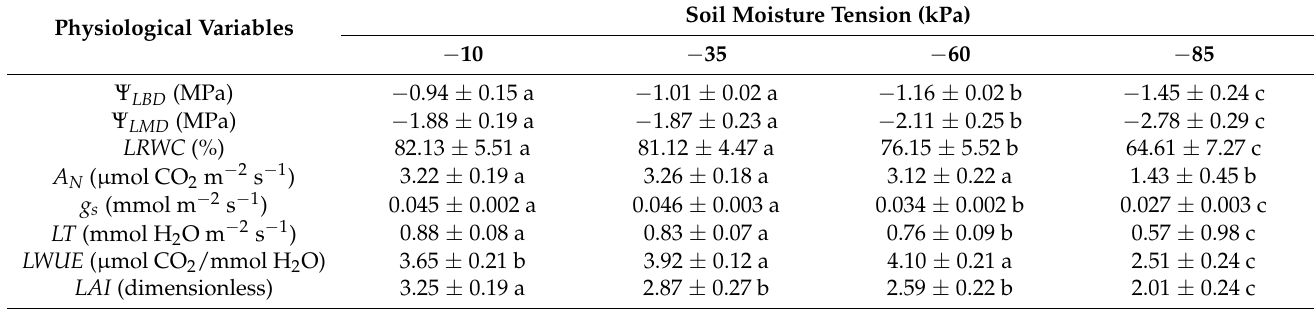
Table 3. Leaf water potential before dawn ( Ψ LBD ) and at midday ( Ψ LMD ), leaf relative water content ( LRWC ), net carbon assimilation rate ( A N ), stomatal conductance ( g s ), leaf transpiration ( LT ), leaf water use efficiency ( LWUE ), and leaf area index ( LAI ) in treatments with the same soil moisture tension during the two phenological